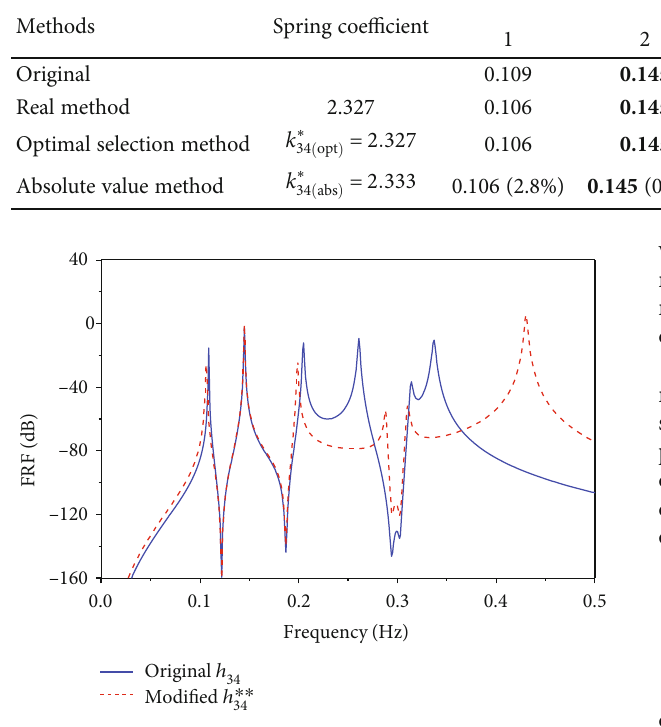
Figure 5: Comparison of exact and modi fi ed FRF h and sti ff ness modi fi cation. Table 3: Necessary spring coe ffi cient k ∗